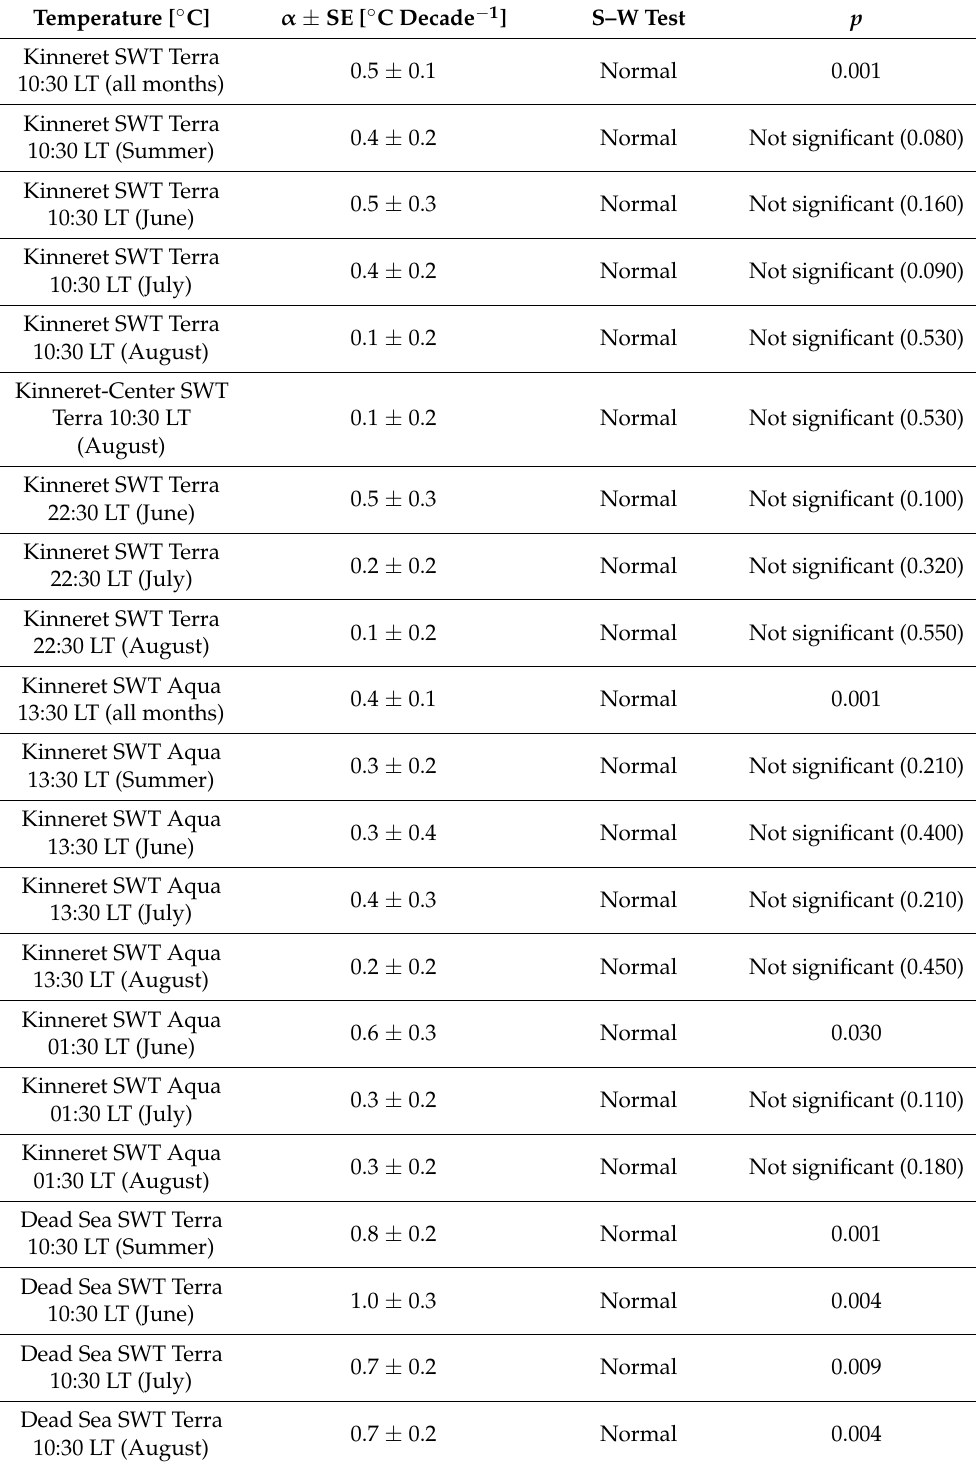
Table A3. The slope ( α ) with its standard error (SE) of the obtained linear fit of deseasonalized monthly anomalies of surface water temperature (SWT) of Lake Kinneret based on satellite data MODIS/Terra and MODIS/Aqua, during the study period (2003–2019). The decision based on the Shapiro-Wilk normality test for residuals (S-W test) and the significance level ( p ) is also displayed. In addition, slopes were obtained for year-to-year variations of MODIS SWT in the summer season and in each summer month separately, both in Lake Kinneret and in the Dead